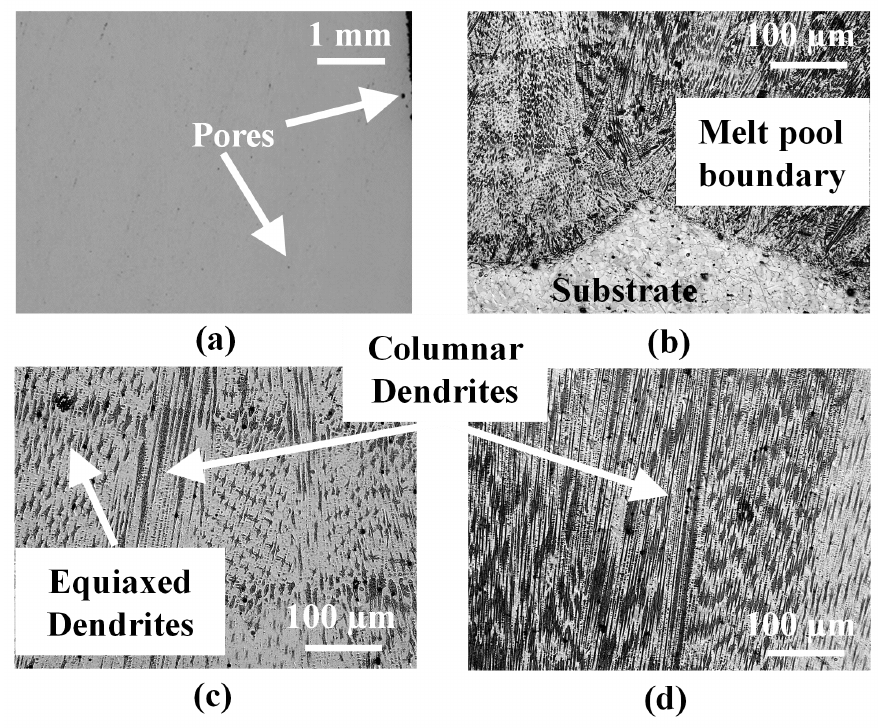
Figure 8. ( a ) Unetched cross-sectional OM image of wire-fed L-DED specimen. Etched OM image of the wire-fed L-DED specimen at: ( b ) the first layer of the deposit and substrate interface. This location has both columnar and equiaxed dendrites with some of the columnar dendrites extending to the deposit-substrate interface; ( c ) near the central region of the deposit showing both columnar and equiaxed dendrites; and ( d ) near the top of the deposit showing columnar